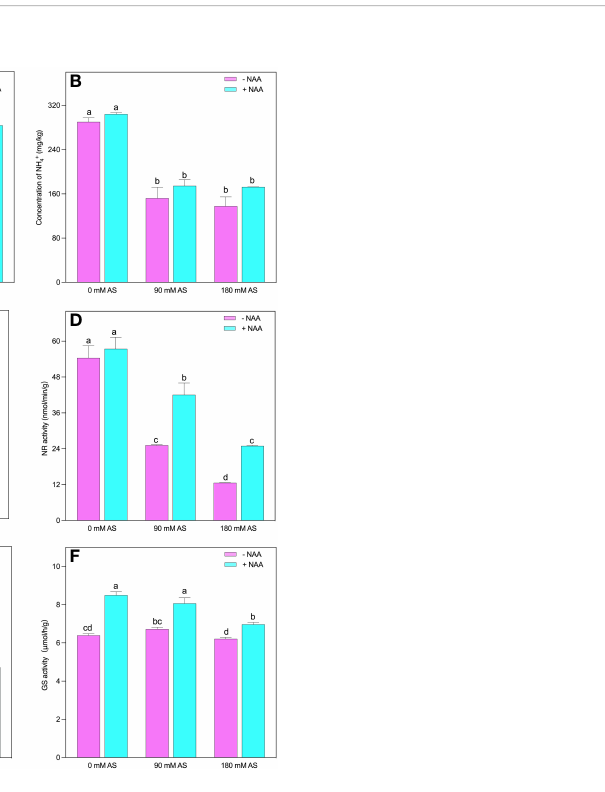
FIGURE 5 Changes in concentrations of (A) NO − 3 and (B) NH + 4 (C) NH + 4 = NO − 3 ratio, and enzymatic activity of (D) NR (E) GS, (F) GOGAT in chufa plants under alkaline stress (AS) and exogenous naphthaleneacetic acid (NAA) application. Bars represents SD of mean, n=3. Different letters indicate signi fi cantly different values at P <0.05 (Duncan ’ s